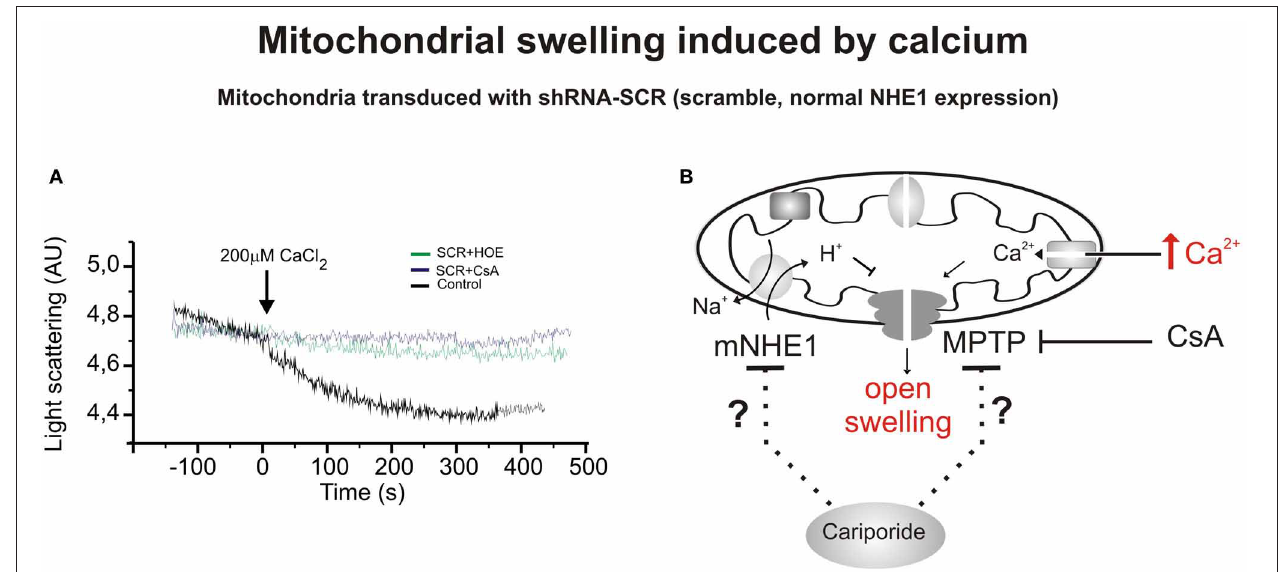
FIGURE 1 | Mitochondrial swelling induced by CaCl 2 . (A) Typical experiment showing the scattered light absorbance traces of Ca 2 + -induced swelling in response to addition of CaCl 2 to heart mitochondria isolated from rats transduced with shRNA-SCR (SCR, scrambled, control) in the presence or absence of cariporide (HOE642, 10 μ M) and Cyclosporine A (CsA, 10mM). Cariporide and Cyclosporine